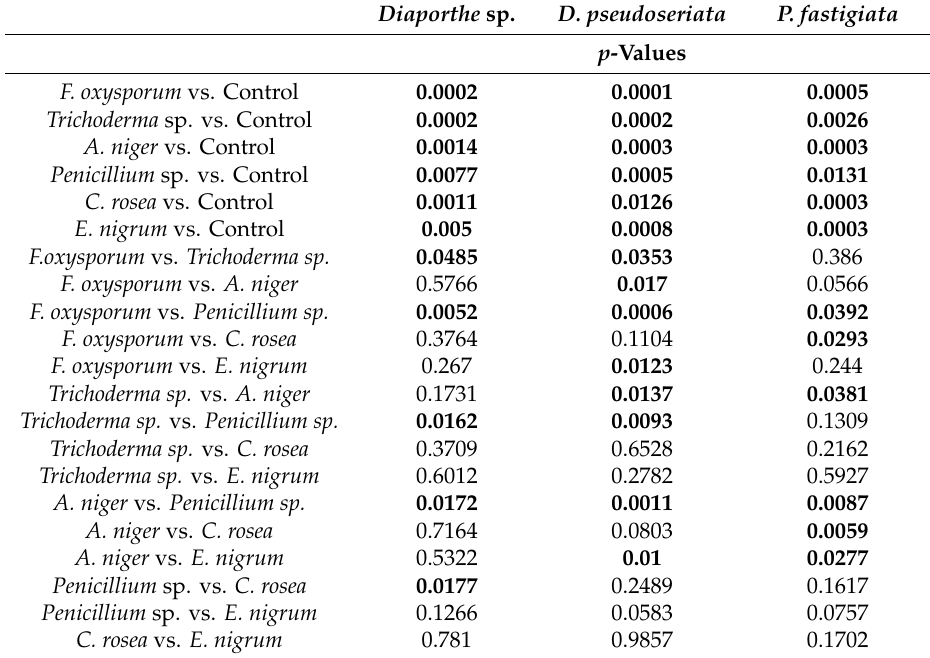
Table 4. Inhibition of Diaporthe sp., Diplodia pseudoseriata , and Phialophora fastigiata by the endophytic fungus Fusarium oxysporum , Trichoderma sp., Aspergillus niger , Penicillium sp., Clonostachys rosea , and Epicocum nigrum . p -values of the one-factor PERMANOVA analysis. Bold values highlight significant di ff erences ( p <